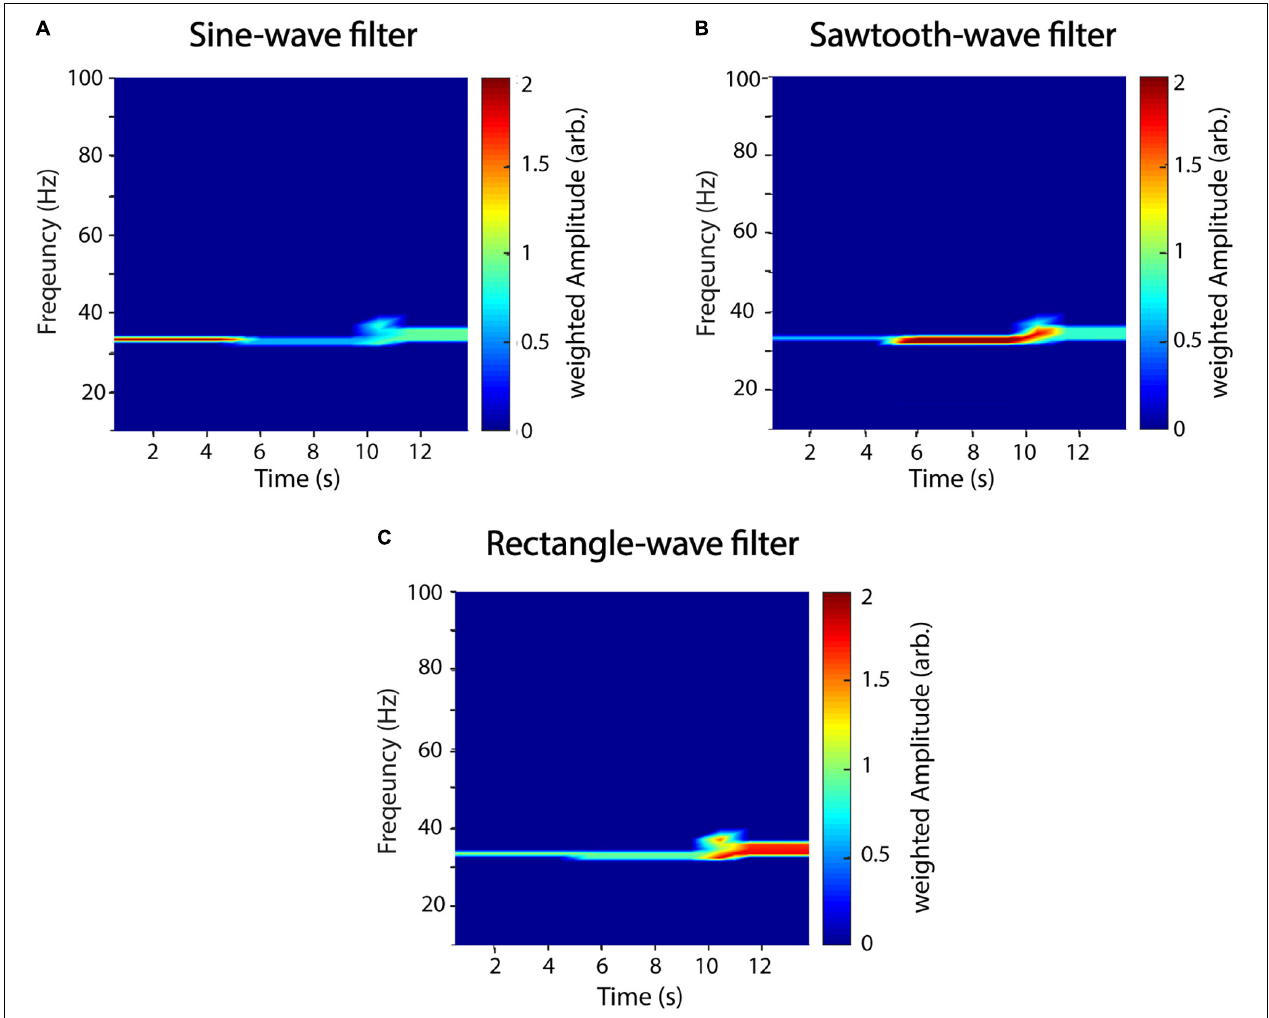
FIGURE 7 | A recurrence amplitude spectrum with templates. The recurrence amplitude spectrum of a compound signal of three 33-Hz oscillatory signals of different shapes and a waveform-dependent gain is shown. The first 5 s is composed of a sine wave, the next 5 s of a sawtooth wave, and the last 5 s of a rectangle wave. Shown are the raw unweighted amplitudes. (A) Five cycles of a sine wave were used as a shape template. (B) Five cycles of a sawtooth wave were used as a shape template. (C) Five cycles of a rectangle wave were used as a shape template. α was always set to 5. Window length was set to 1 s with a 50% overlap.